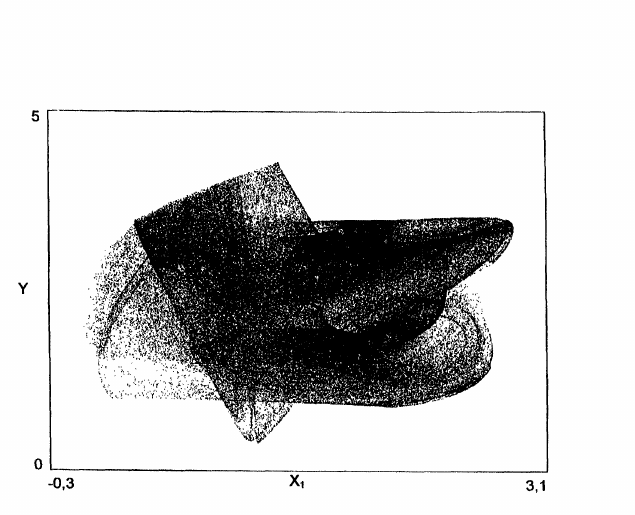
FIGURE Poincar6 cross-section of hyperchaotic flow in x2 0 with al 0.0, a2 --0.3, DI b2